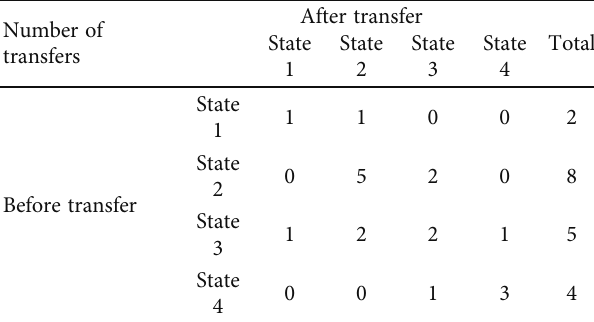
Table 4: Transfer of exercise energy